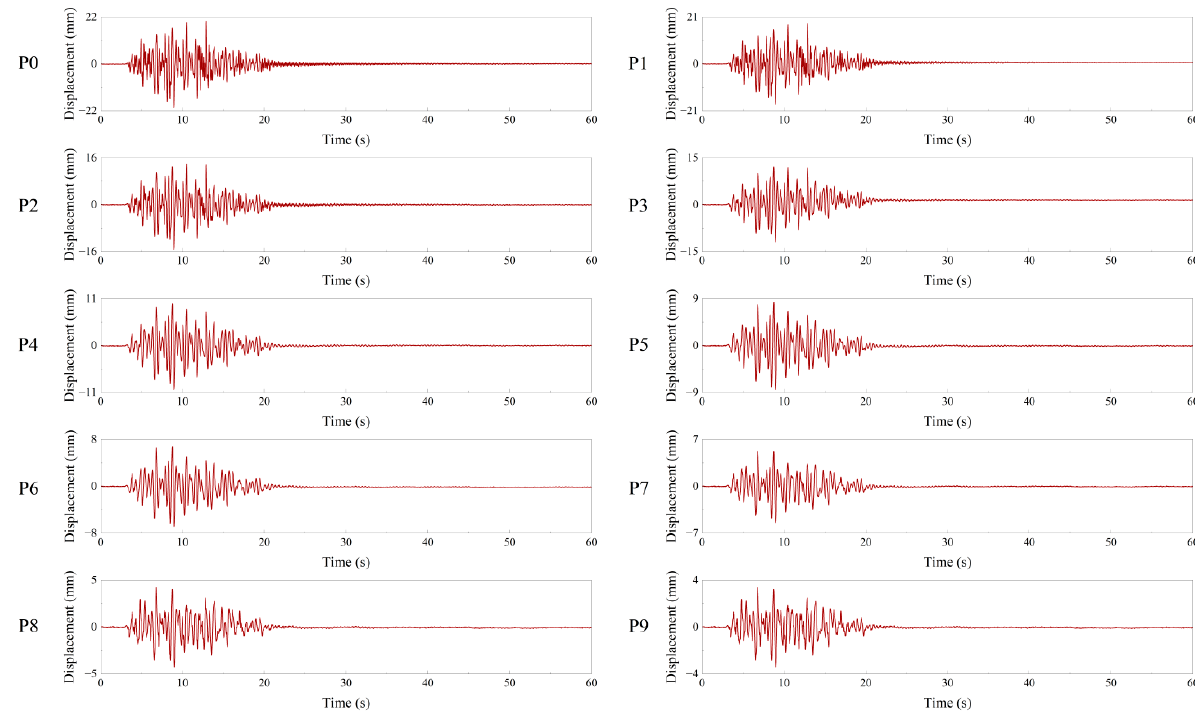
Figure 25. Smartphone monitoring wind turbine structure responses. Table 4. Response peak value obtained by two monitoring methods.